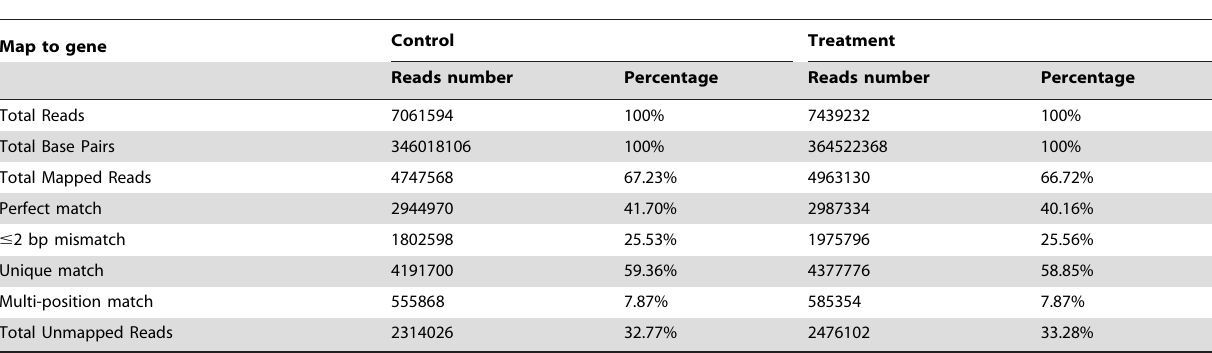
Table 1. Statistics of mapping to reference transcriptome for each